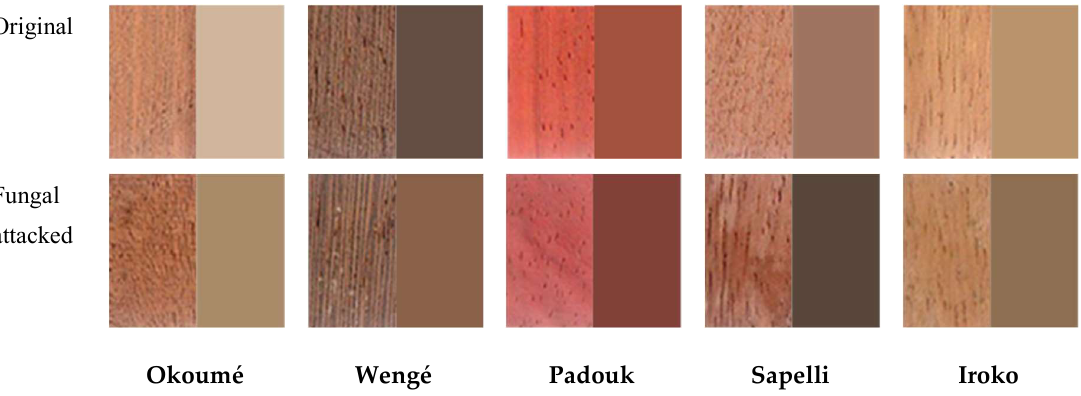
Figure 3. Visualization and pantone swatches of the top surfaces of selected tropical woods before and after exposure to C. puteana .